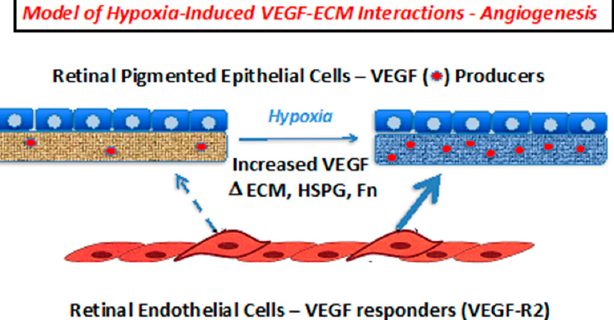
Figure 8. Proposed model for paracrine control of choroidal neovascularization via alterations in VEGF deposition within the RPE ECM. Hypoxia results in increased VEGF expression, and changes in the capacity of the RPE ECM to bind to VEGF. The increased VEGF-laden matrix may then selectively bind to VEGFR2 on endothelial and endothelial progenitor cells to facilitate the interaction with the ECM and ultimately,